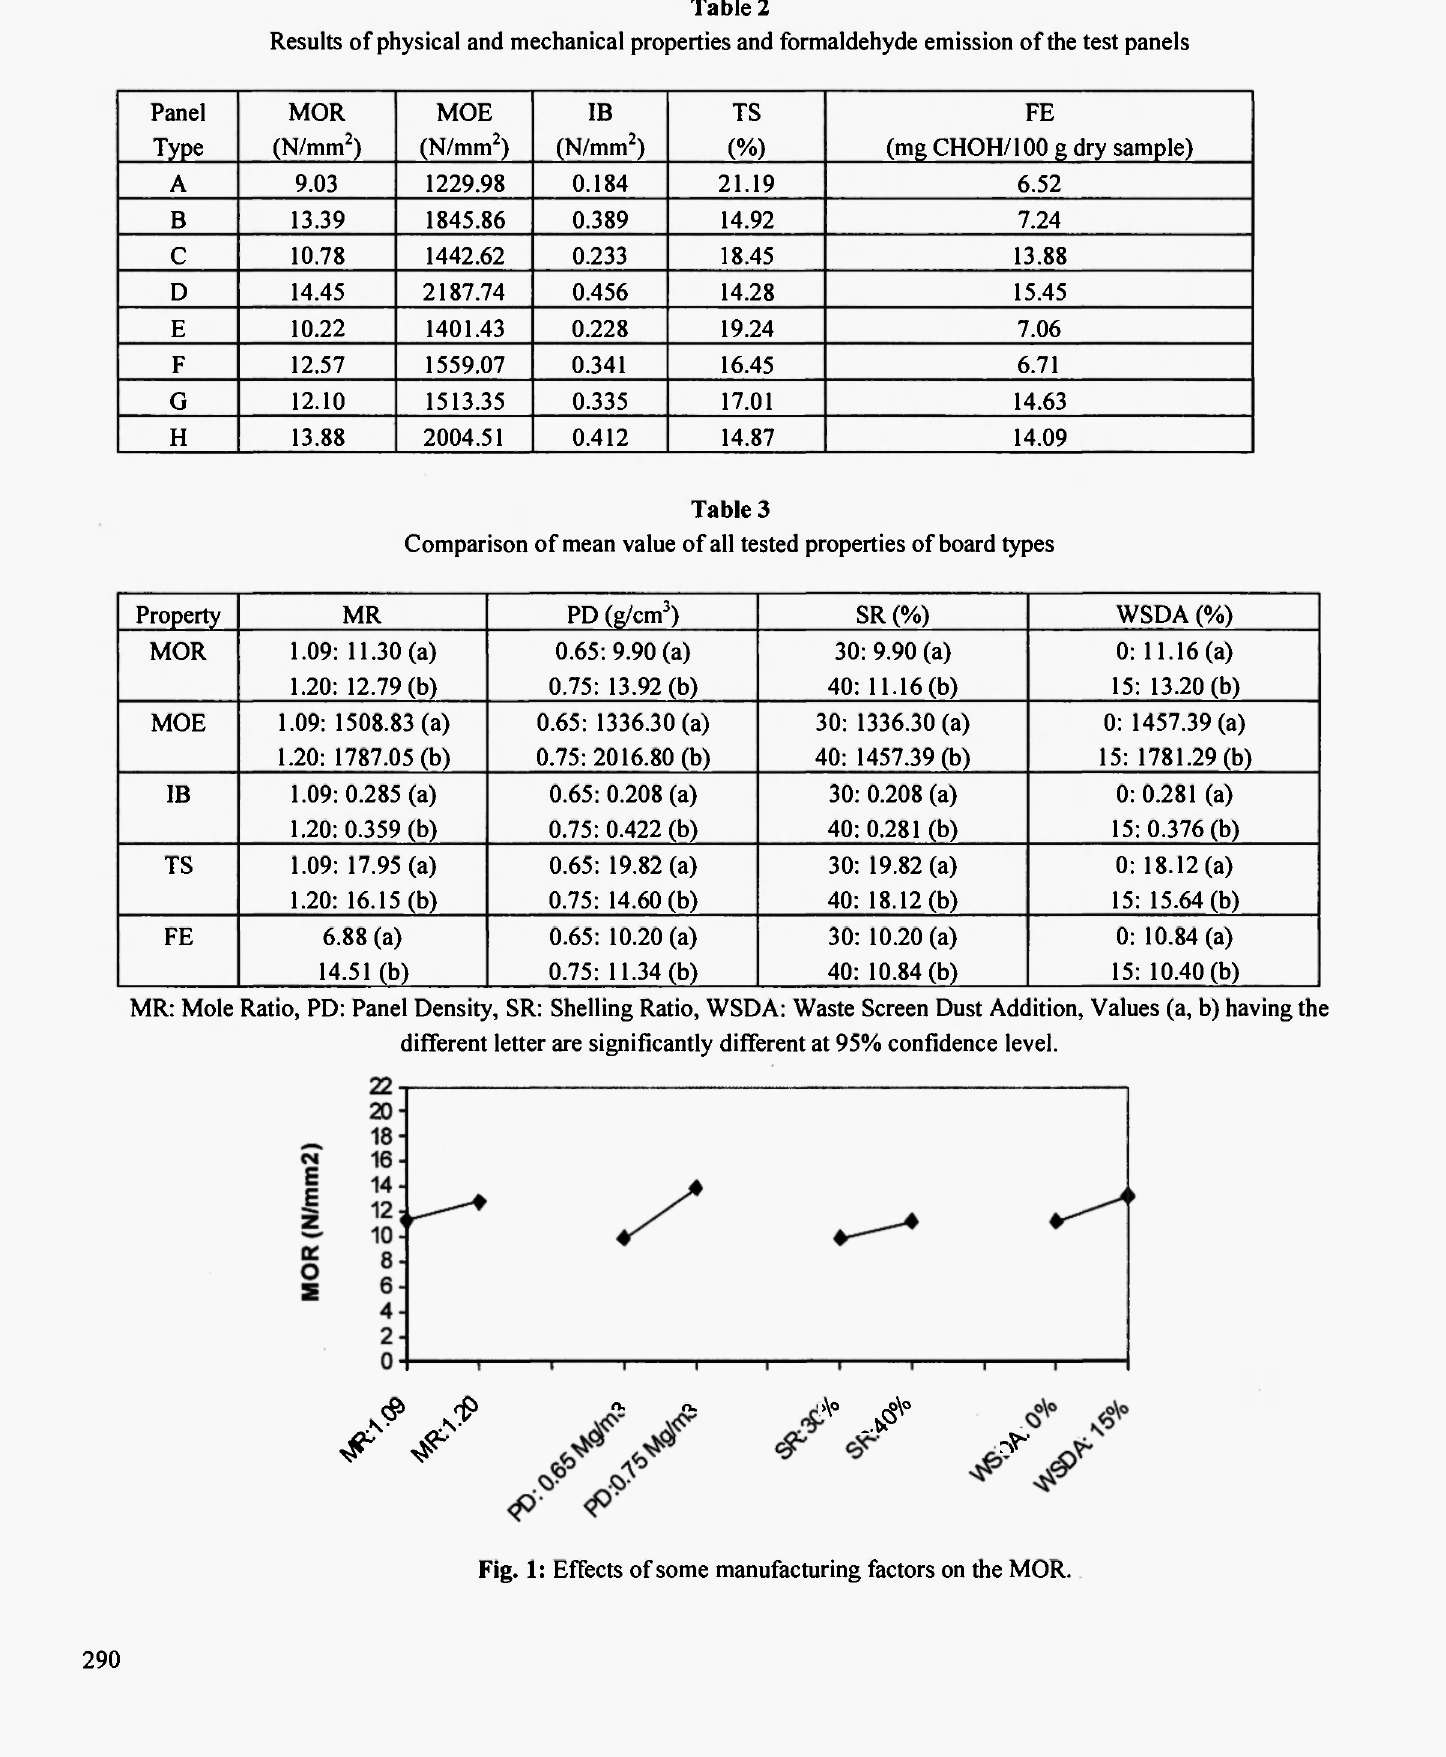
Results of physical and mechanical properties and formaldehyde emission of the test panels